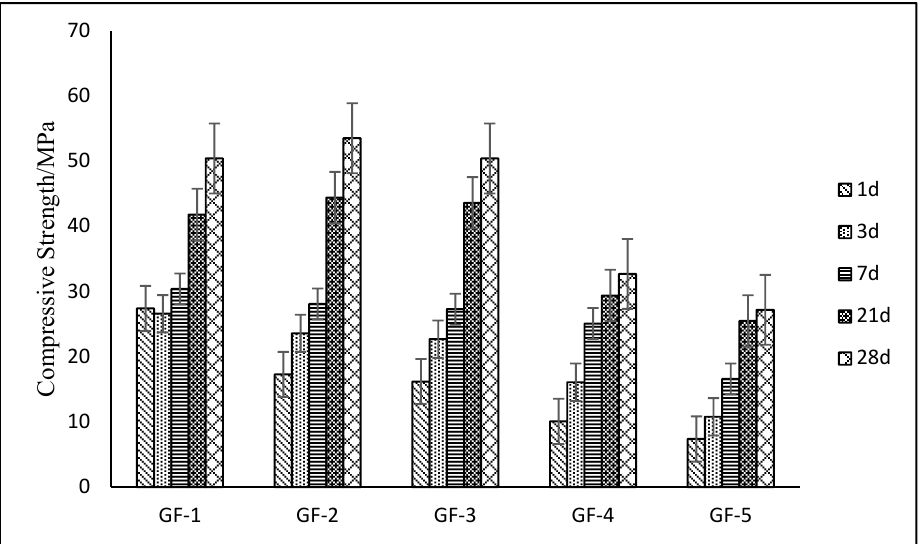
Figure 5. Compressive strength of HBSC pastes.